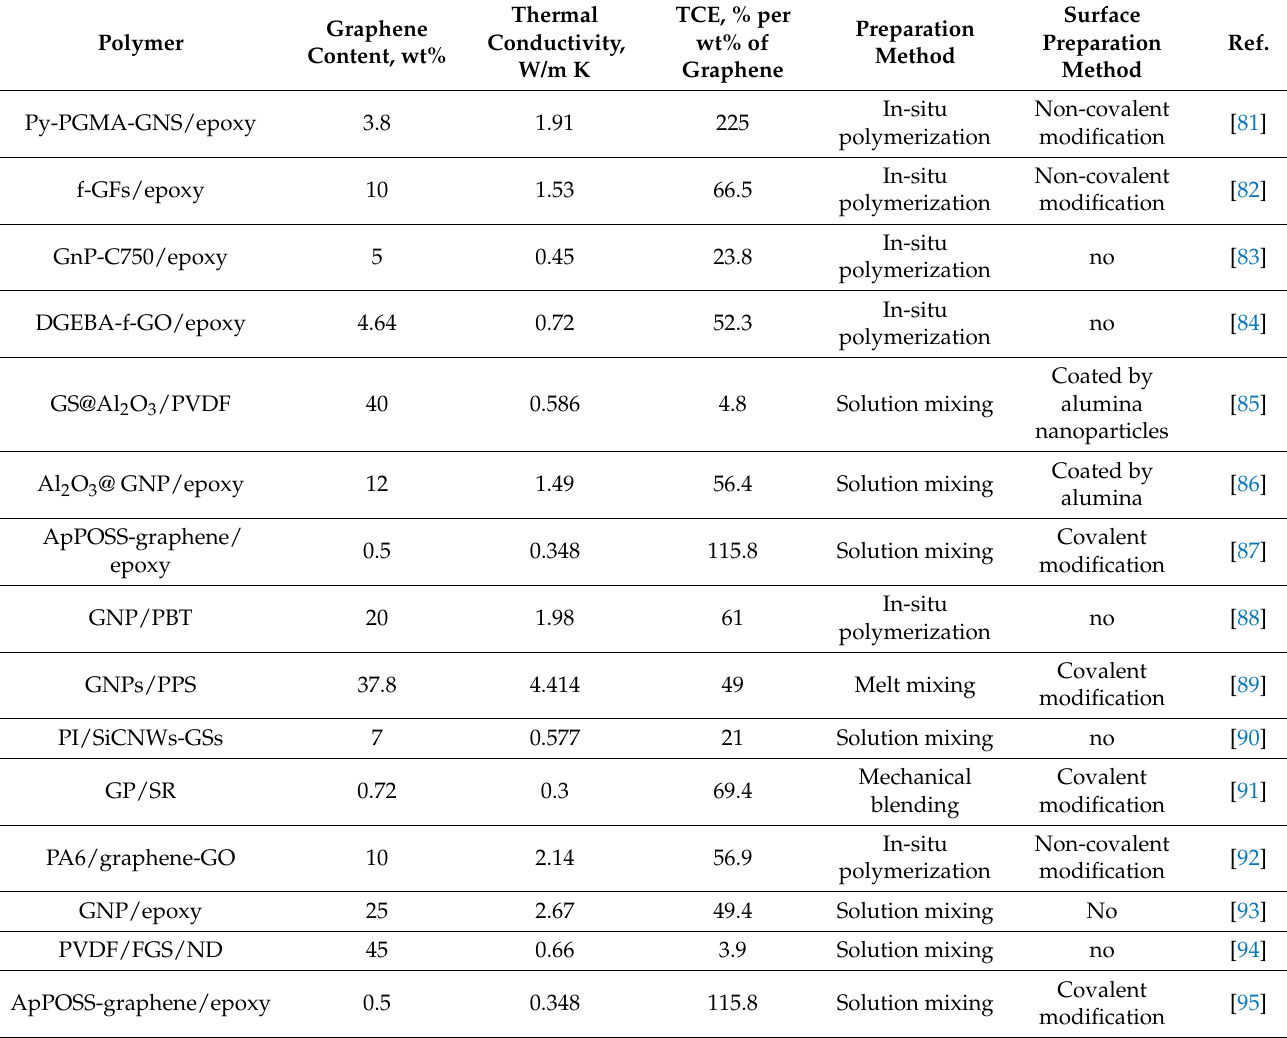
Table 5. Parameters of polymer composites with a random orientation of graphene